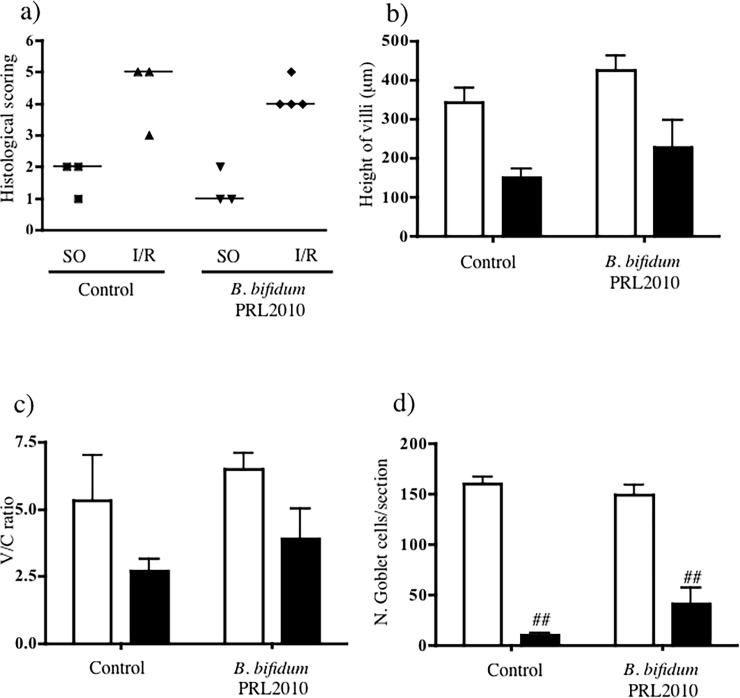
Intestinal morphometry.Panel a represents histological damage scoring of intestinal sections (horizontal bar at the median value) according to Chiu’s score [26]. Height of villi (μm) (b), V/C ratio (c) and number of Goblet cells (d) in intestinal tissues excised from SO (white columns) and I/R (black columns) mice orally administered with vehicle (Control) or supplemented with B. bifidum PRL2010 (n = 3–4 animals per group). Two-way ANOVA followed by Bonferroni’s post test: ##P<0.01 vs. corresponding SO mice.